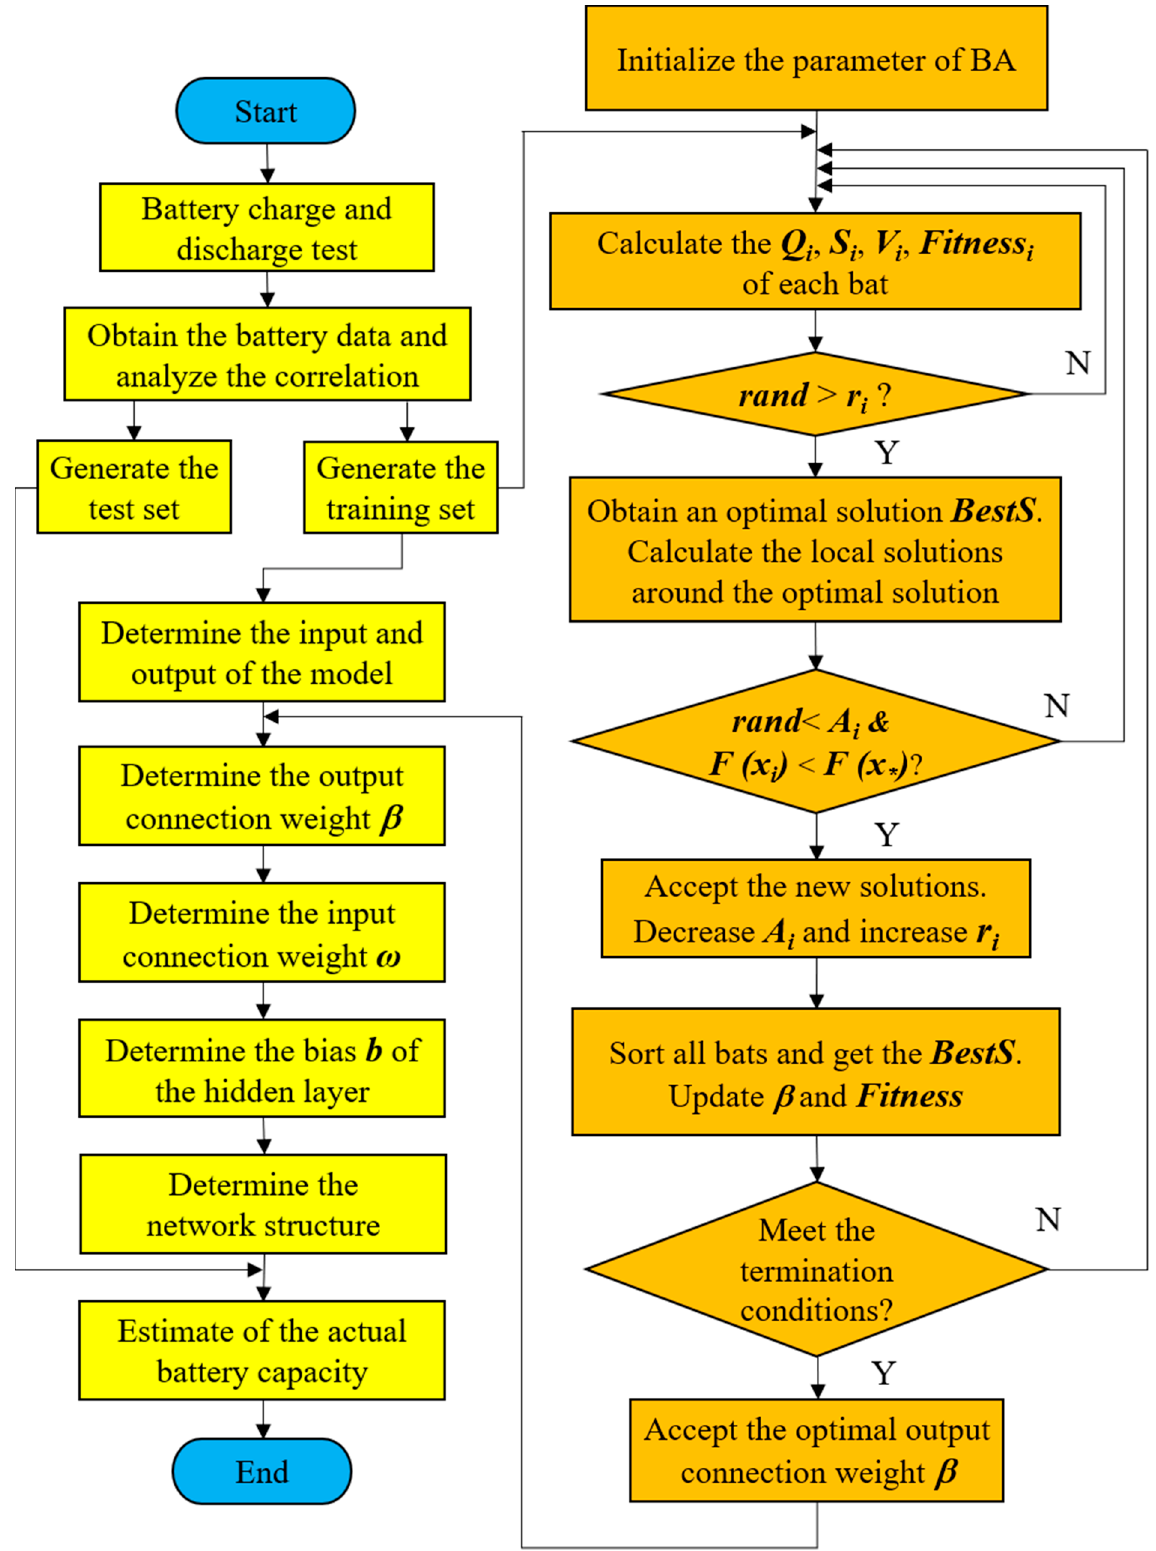
Figure 11. Algorithmic process of BA-ELM .